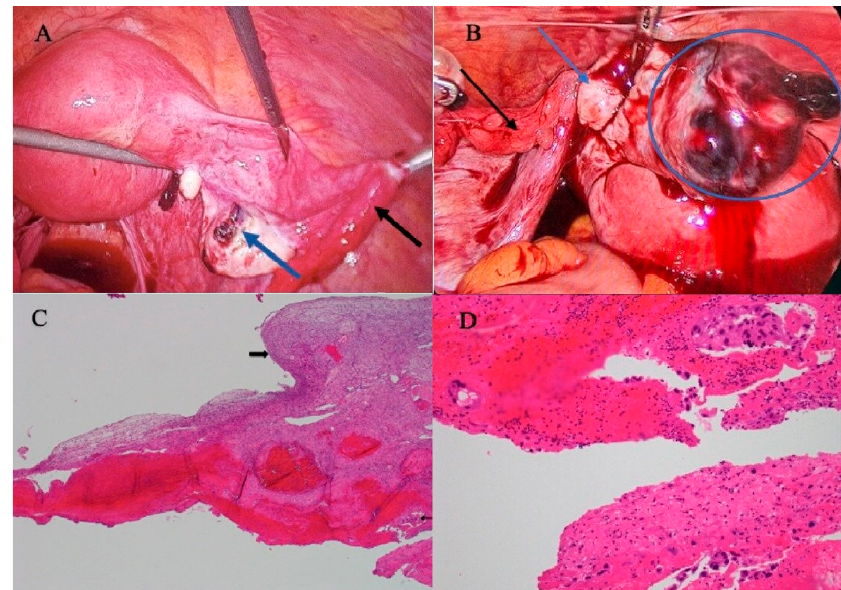
Figure 2. Case 1 illustrates that the laparoscopic recognition of an ovarian pregnancy can be difficult. ( A ) A normal right fallopian tube (black arrow), and on the right ovary, a lesion which was not recognised as an ovarian pregnancy (blue arrow). ( B ) An enlarged picture with a normal right oviduct (black arrow), and a right ovary (blue arrow) with a lesion not recognised as a ruptured ovarian pregnancy (blue circle). ( C ) On the histological examination of the excised lesion, a cyst-like wall lined by fibrinous hemorrhagic material is seen with scattered trophoblastic nests (thin arrow) overlying the ovarian edematous stroma with a primordial follicle (thick arrow) and covered with a mesothelial lining (hematoxylin and eosin (H&E) stain, original magnification × 40). ( D ) Foci of trophoblastic elements are embedded within a fibrinous inflamed decidualized tissue (H&E, ×200).